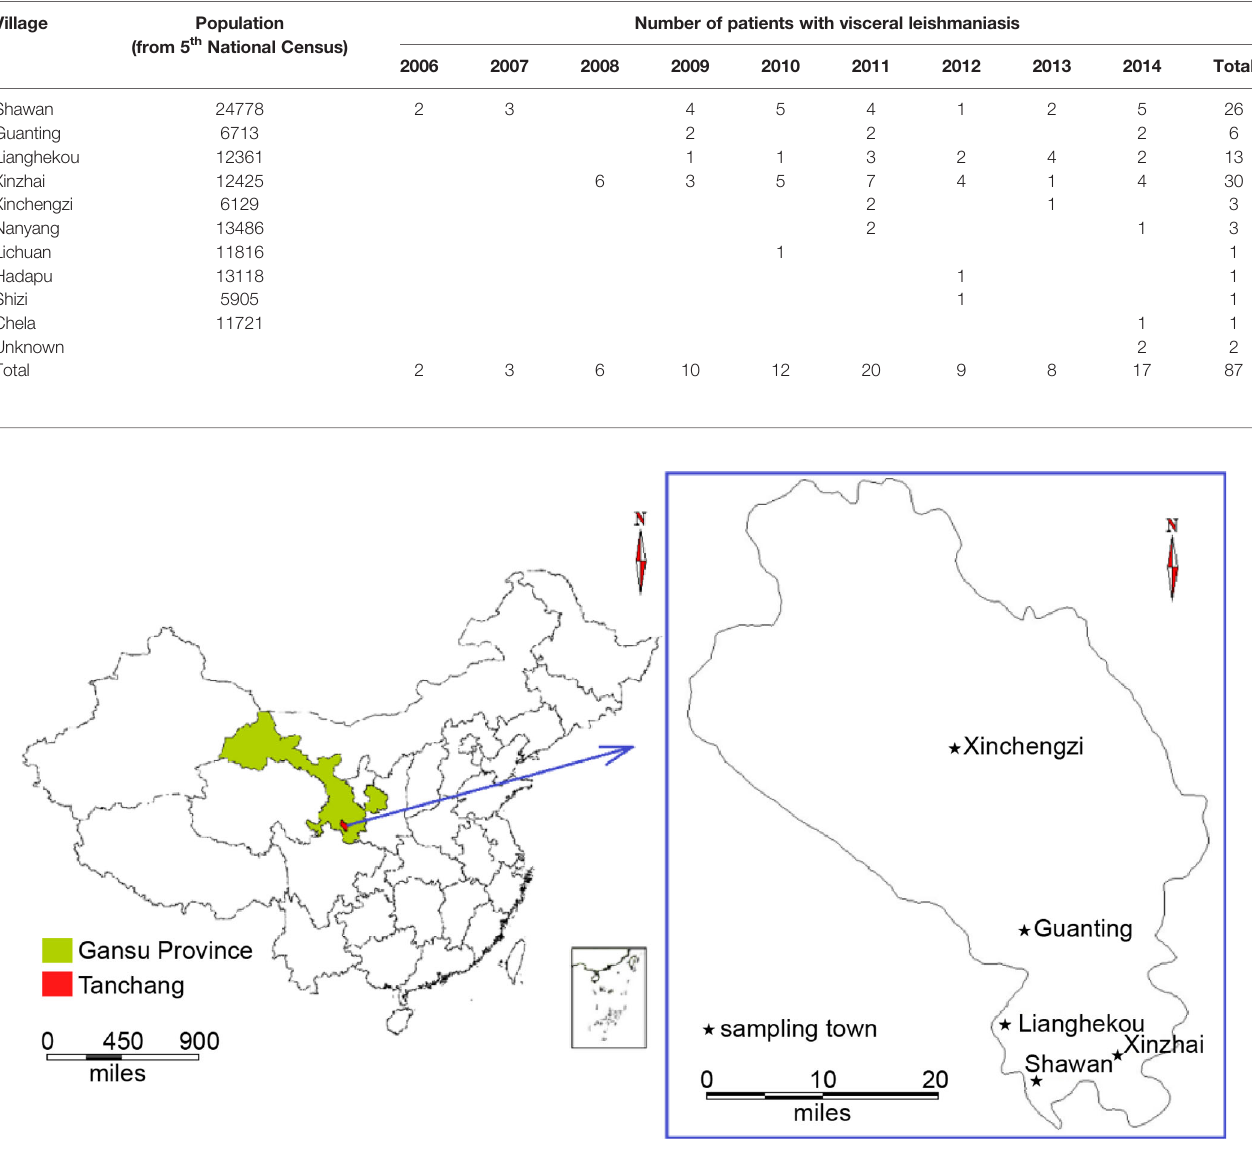
Number of patients with visceral